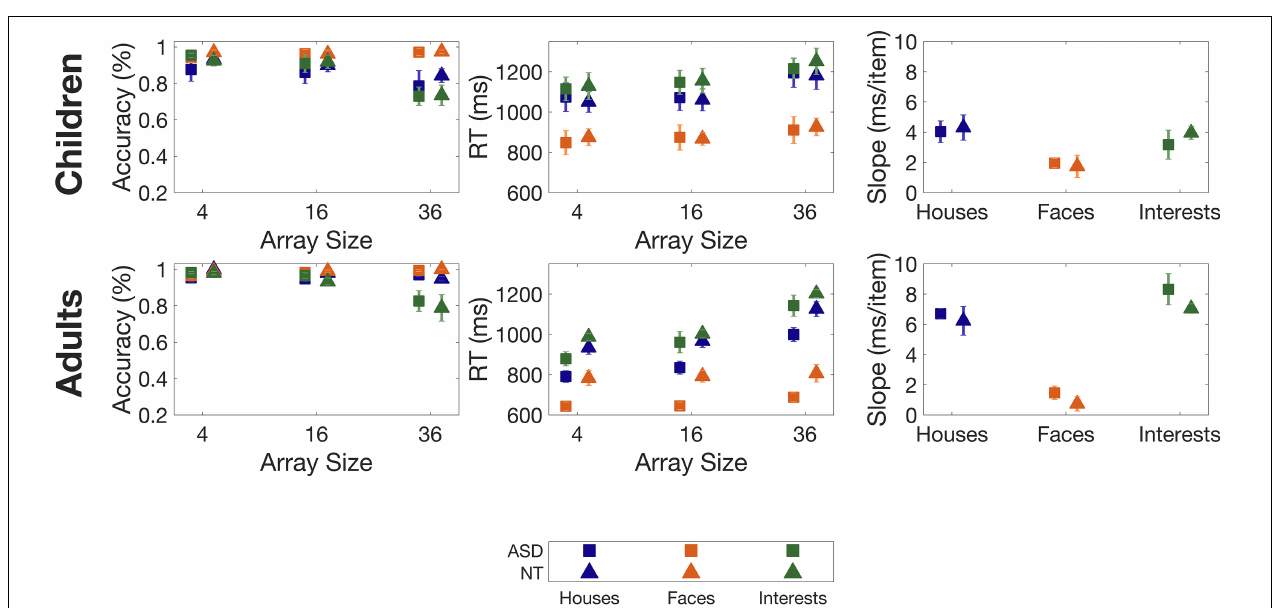
FIGURE 2 | Accuracies, Reaction Times (RTs) and slopes for the category task, for children (top panels) and adults (bottom panels). Slopes are determined from a least-squares regression of RT vs. array size. Error bars indicate 1 Standard Error of the Mean.